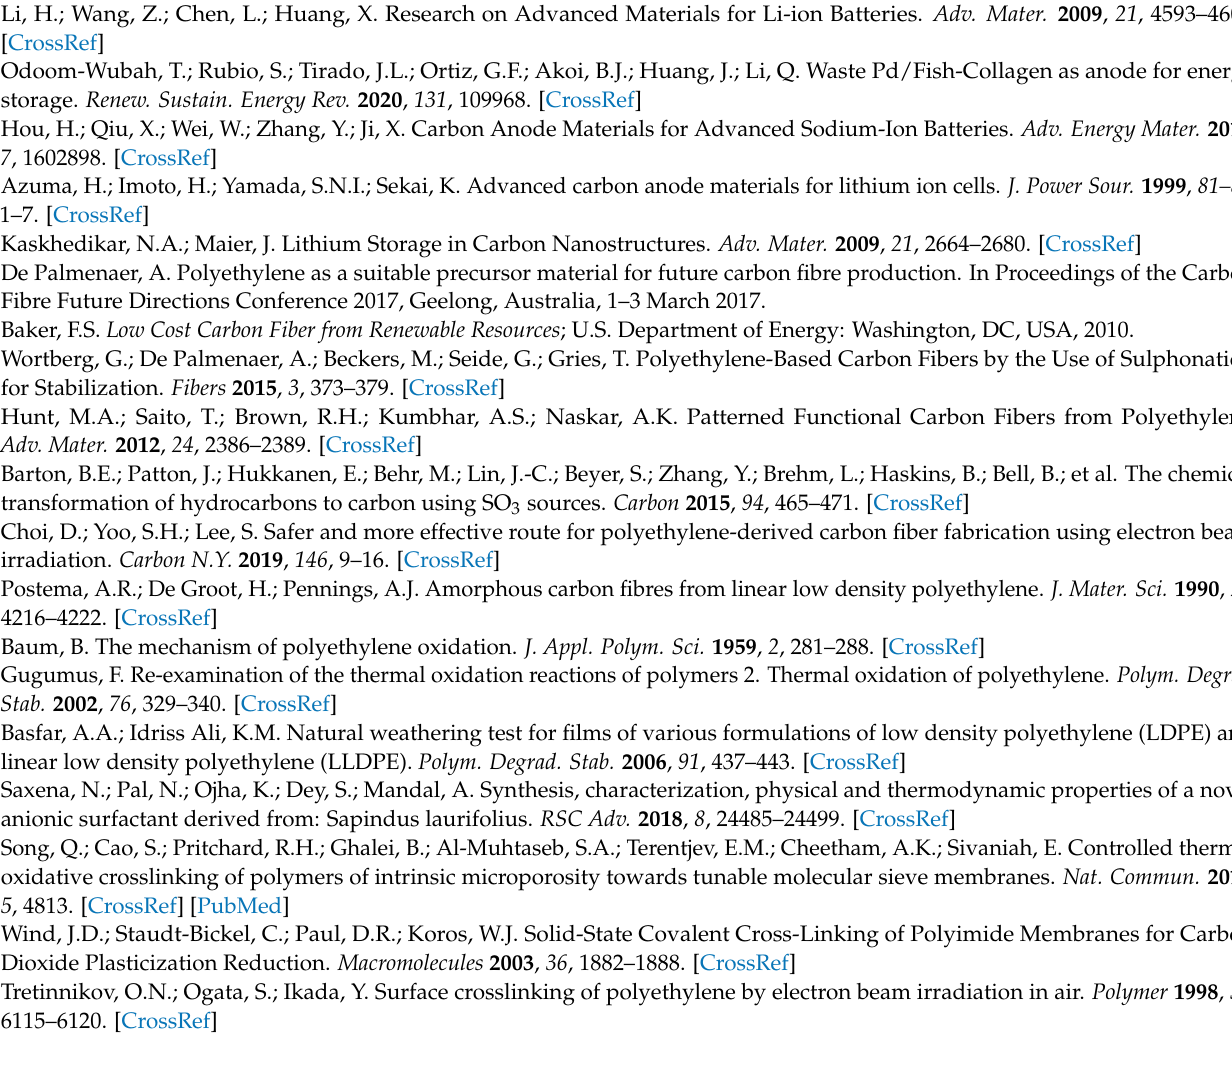
time. Figure S2: FT-IR results for PE samples with varied sulfonation time. Figure S3: Representative scanning electron microscopy (SEM) image of ball-milled PE carbon. Figure S4: Powder electrical conductivity measurement of PE samples sulfonated for varied temperatures and times. Figure S5: XRD analysis results for sulfonated PE samples carbonized at various